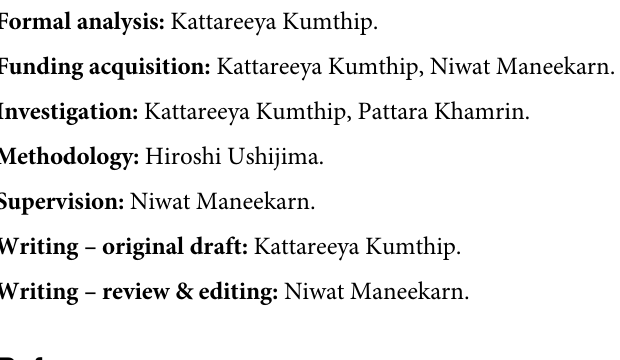
Fig 5. Phylogenetic tree of partial nucleotide sequences (429 bp) of the hexon gene. Human adenovirus strains detected in Thailand between 2011 and 2017 (165 sequences) and other 41 adenovirus reference strains (bold) are